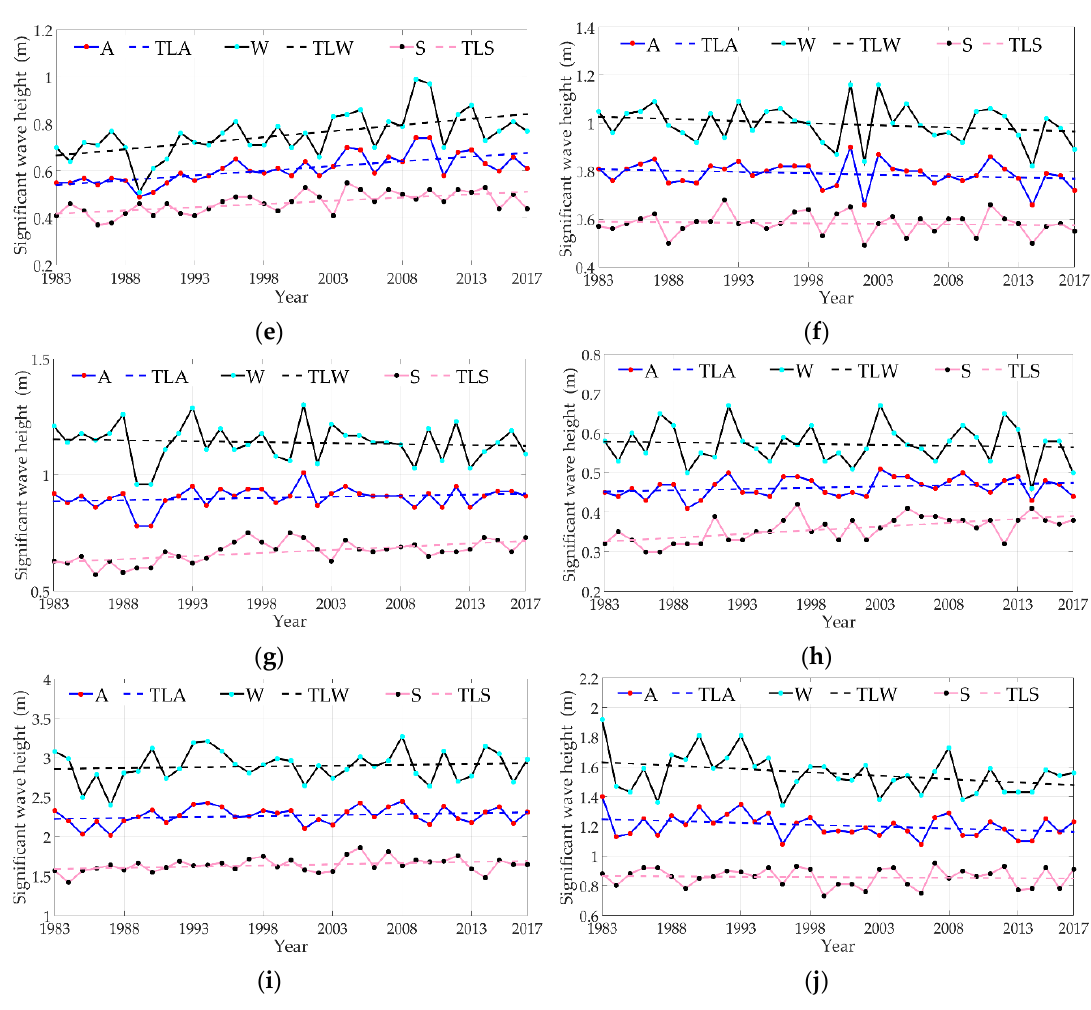
Figure 8. Representation of the significant wave height (Hs) for the annual averages (A), winter (W), and summer (S) seasons corresponding to the most representative points; ( a ) A3, Balearic Sea; ( b ) B1, Ligurian Sea; ( c ) C4, Tyrrhenian Sea; ( d ) D3, Adriatic Sea; ( e ) E3, Ionian Sea; ( f ) F1, Aegean Sea; ( g ) G1 Black Sea; ( h ) H2, Levantine Sea; ( i ) I1, North Sea; and ( j ) J2, Baltic Sea. TLA represents the trend line for the annual averages, while TLW and TLS are the trend lines for the winter and summer seasons, respectively. Results corresponding to the 35-year time interval 1983 – 2017.